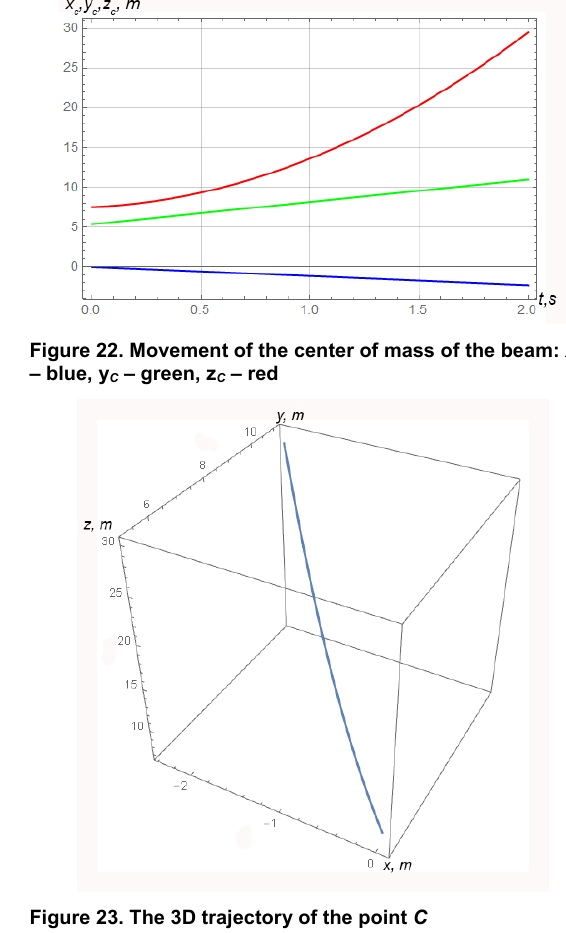
Figure 23. The 3D trajectory of the point